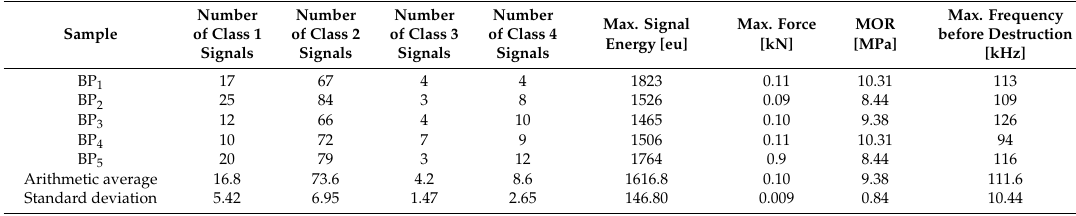
Table 7. Summary of research results for BP samples.